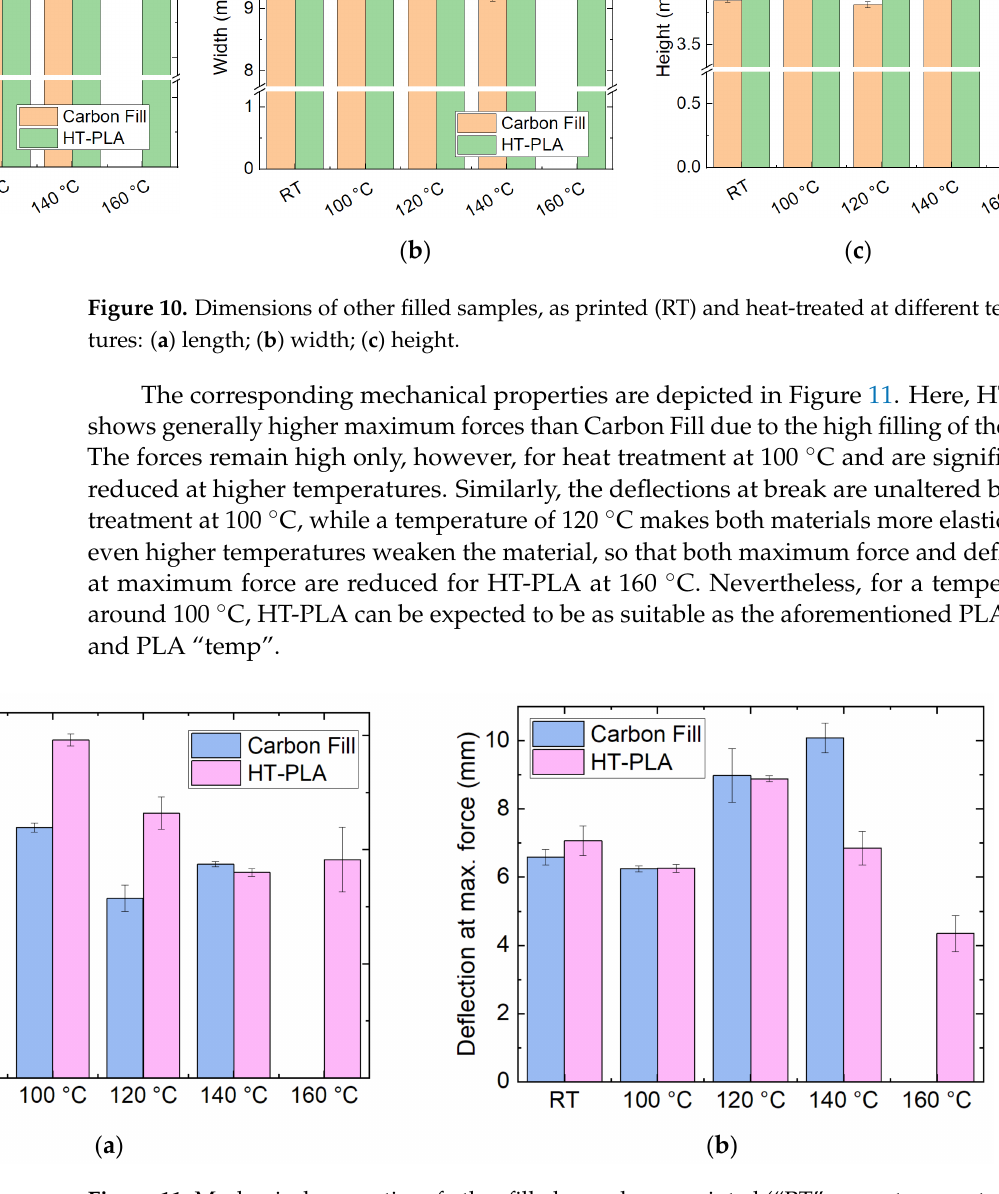
Figure 9. Mechanical properties of filled PLA samples, as printed (RT) and heat-treated at different temperatures: ( a ) maximum force; ( b ) deflection at maximum force in 3-point bending tests.